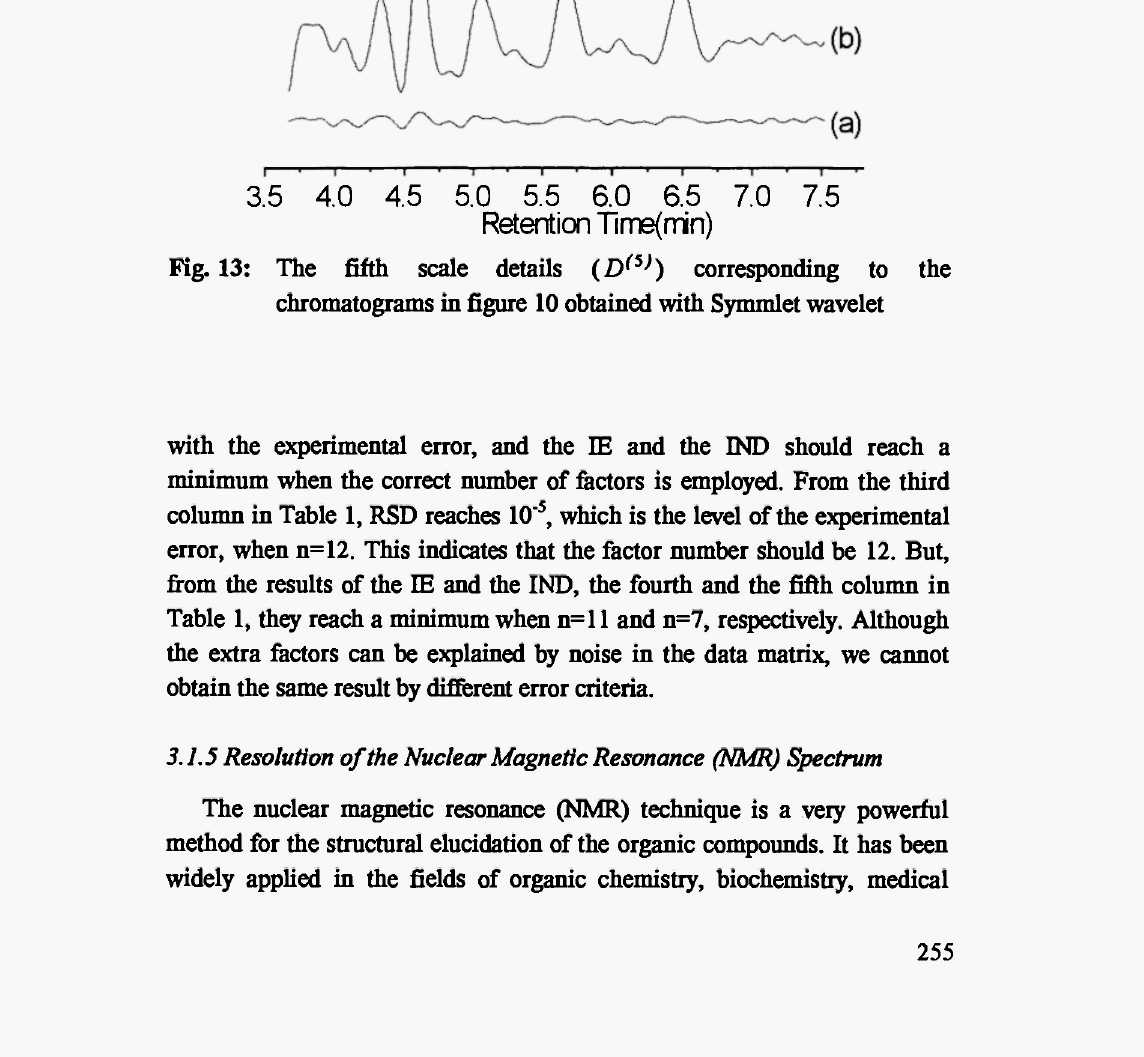
Fig. 13: The fifth scale details (D {5} ) corresponding to the chromatograms in figure 10 obtained with Symmlet wavelet